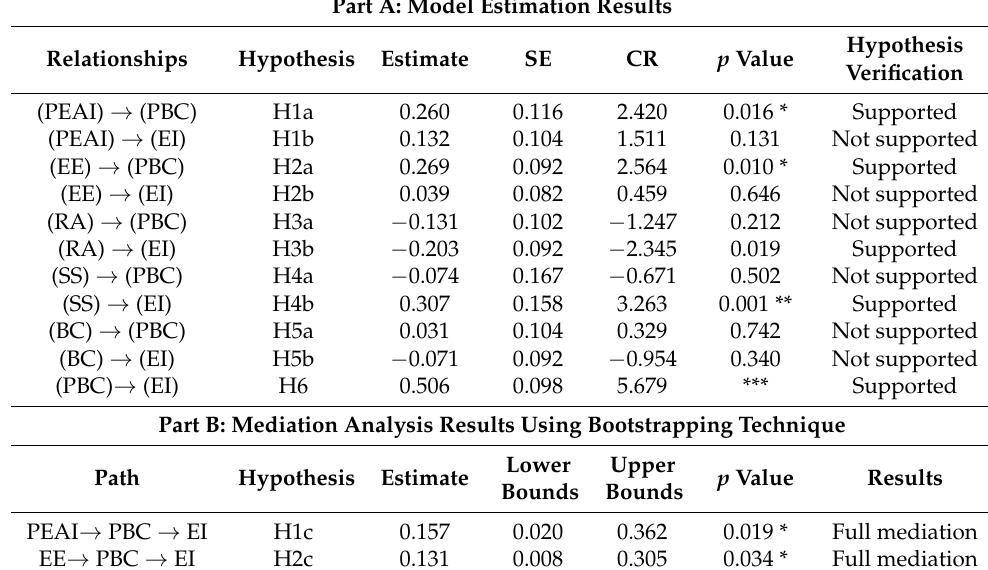
Table 3. Estimation